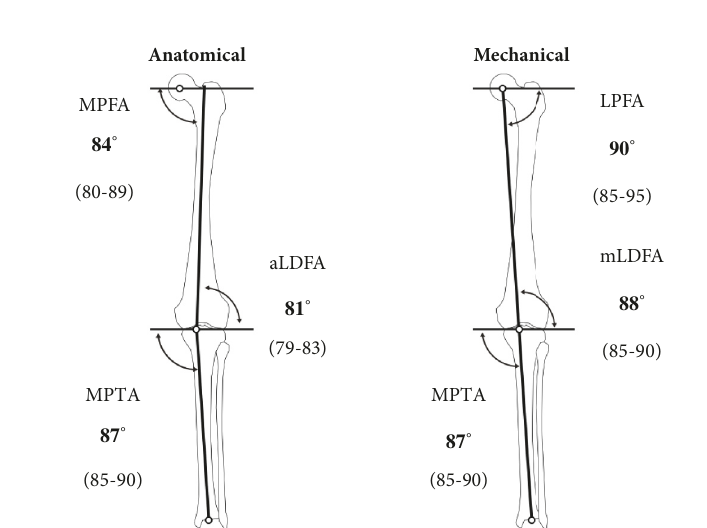
Figure 1: Normal lower limb alignment by Paley D.